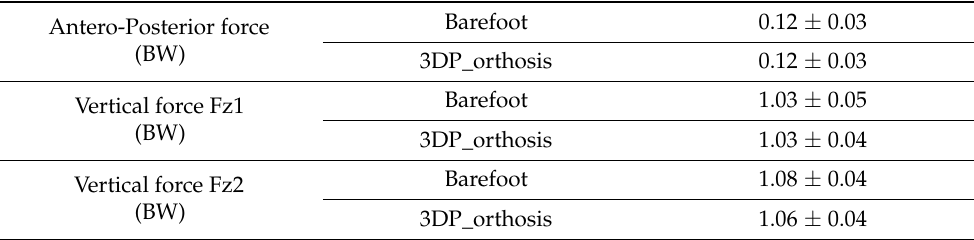
Table 1. Comparison of the maximum ground reaction force (GRF) between the barefoot group and the 3DP_orthosis